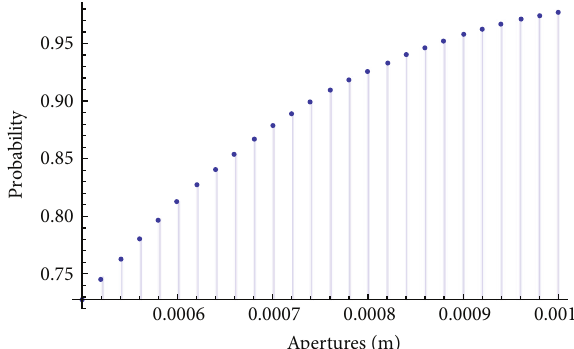
Figure 7: Selected aperture via the Latin hypercube sampling and its corresponding probability.